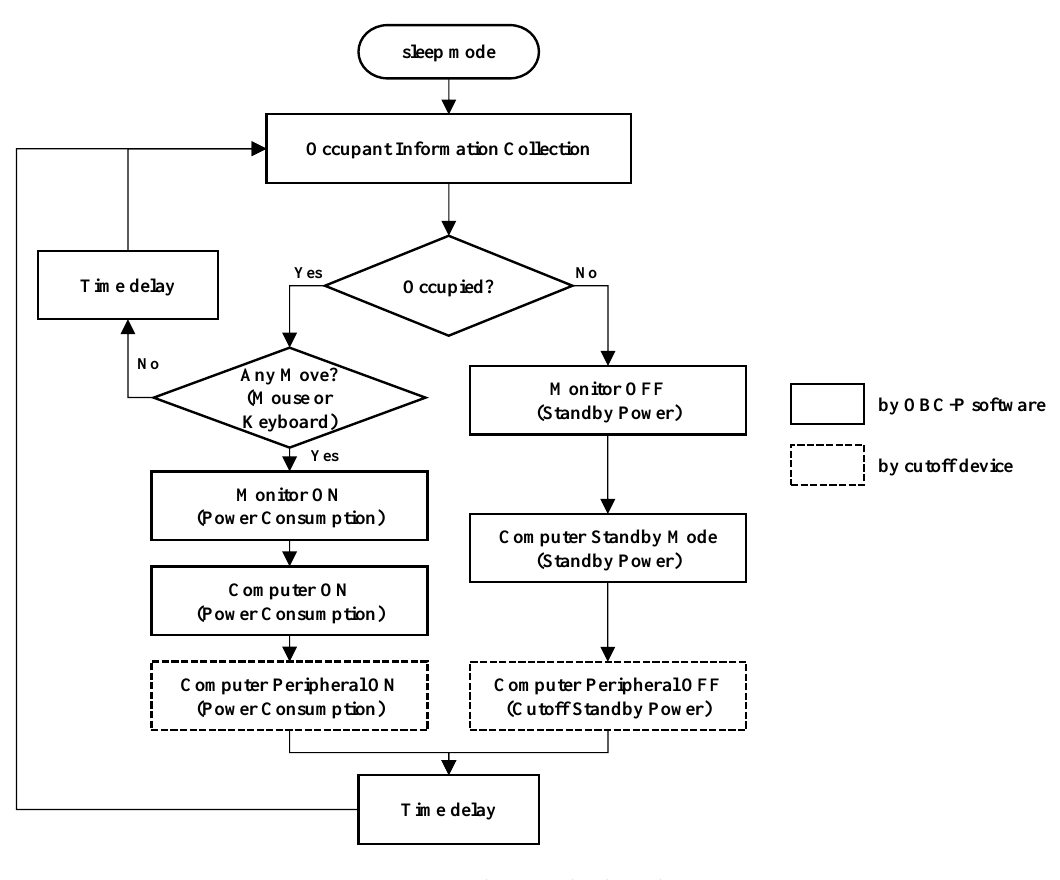
Figure 13. Sleep mode algorithm.